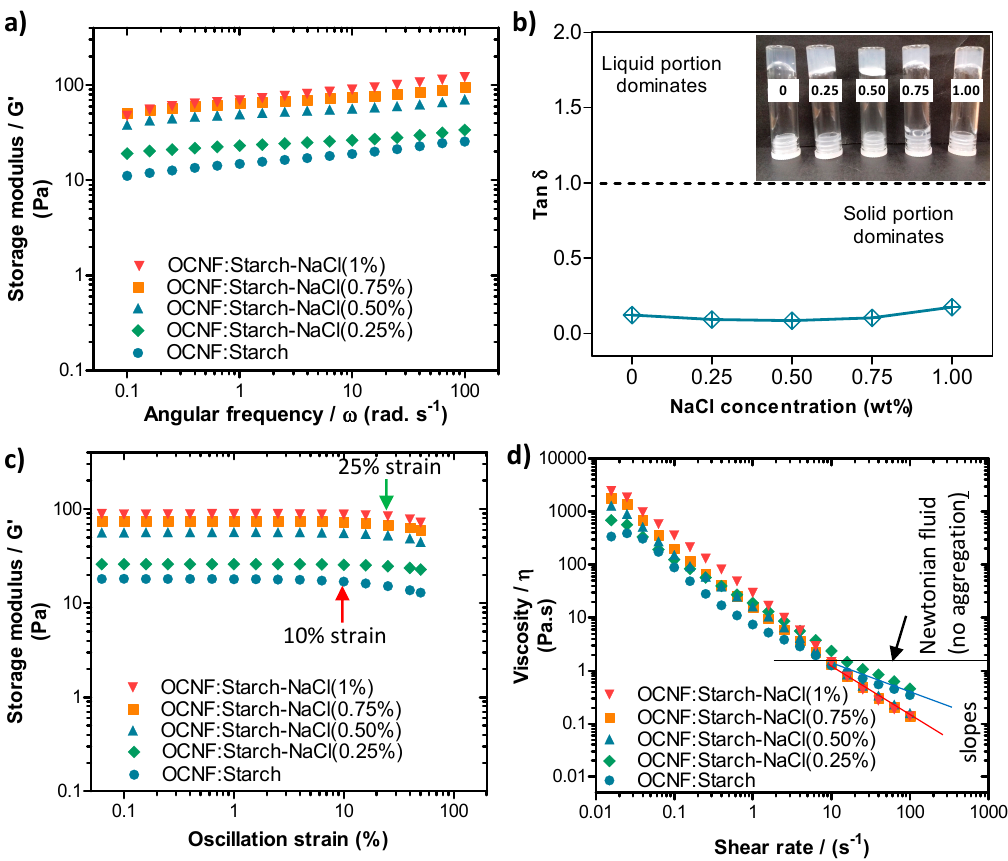
Figure 4. ( a ) Oscillatory frequency sweeps, ( b ) tan δ values obtained at a frequency of 1 Hz (6.28 rad s − 1 ), ( c ) amplitude sweeps, and ( d ) shear flow curves of OCNF:starch (1:1 wt%)/NaCl (0, 0.25, 0.5, 0.75, and 1 wt%) hydrogels. Inset in ( b ) is a photograph of the different samples, labelled by their salt concentration (in wt%).